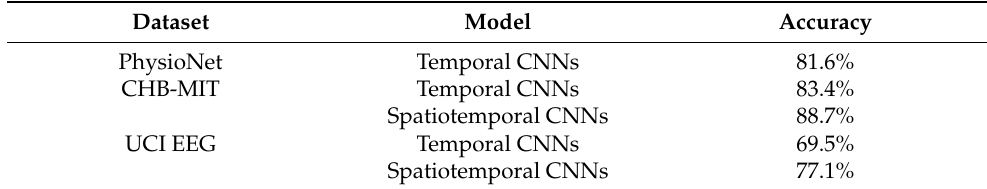
Table 3. Classification accuracy of models for three datasets.